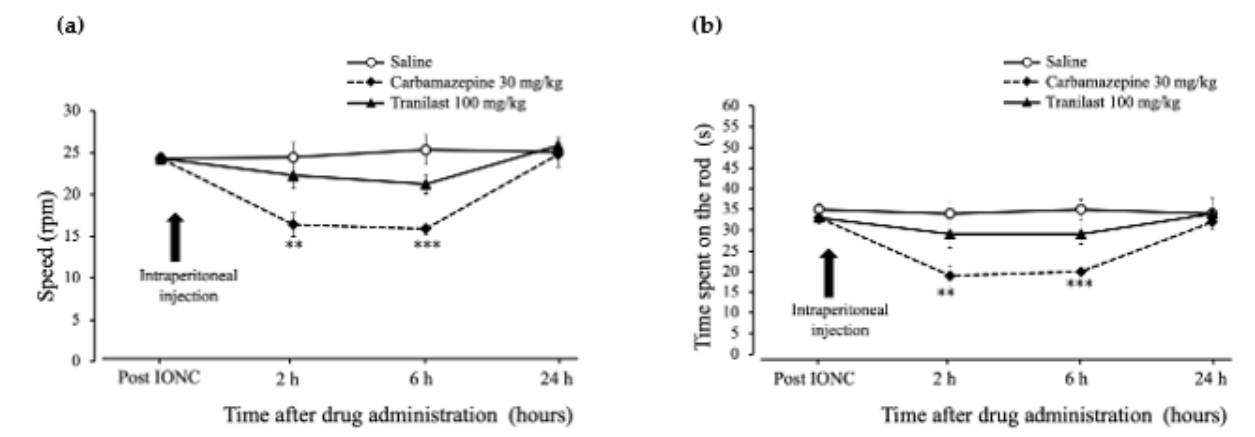
Figure 5. Rotarod performance test. ( a ) Changes in speed (rotations per minute (rpm)) and ( b ) change in time spent on the rod (seconds (s)) following intraperitoneal tranilast (100 mg/kg), carbamazepine (30 mg/kg), or saline injections at different times (2, 6 and 24 h) in the neuropathic pain model. Reduced speed and time spent on the rod were observed in the carbamazepine group compared to the saline group at 2 and 6 h. No significant changes are seen in the tranilast group. Values are presented as mean ± SEM. n = 6 per group. ** p < 0.01, *** p < 0.001, repeated measures analysis of variance followed by Tukey’s HSD test.